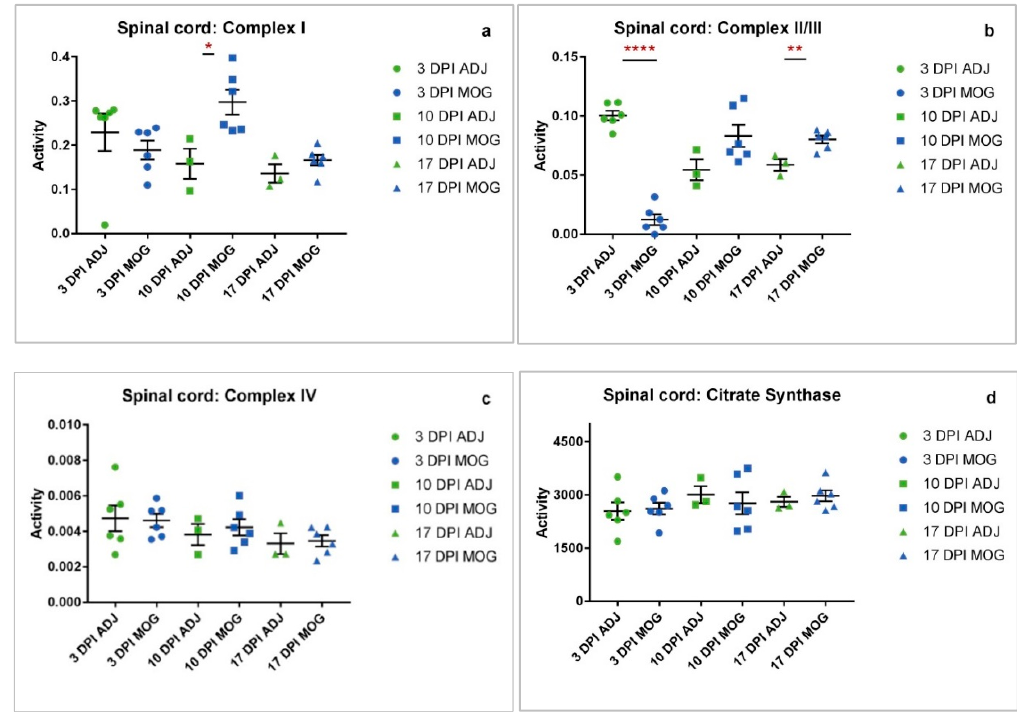
Figure 1. Spinal cord complex activity adjuvant (ADJ) vs myelin oligodendrocyte glycoprotein (MOG) at different time-points. Individual raw data points for controls (ADJ) (green) and diseased (MOG) (red) have been plotted with mean and standard error of mean (SEM) to show the distribution of complex activity. Activities shown are expressed as a ratio to citrate synthase (CS) activity. ( a ) Graph showing distribution of complex I activity across ADJ and MOG. Complex I activity in MOG animals was significantly increased at 10 DPI (* p = 0.0209). ( b ) Complex II/III activity in MOG animals was severely decreased at 3 DPI (**** p < 0.0001), and significantly increased at 17 DPI (** p = 0.0072). ( c ) Complex IV activity showed no significant differences between MOG and ADJ animals across all 3 time-points. ( d ) Mitochondrial enrichment was measured by citrate synthase activity, which showed no significant differences in the spinal cord between MOG and ADJ animals.